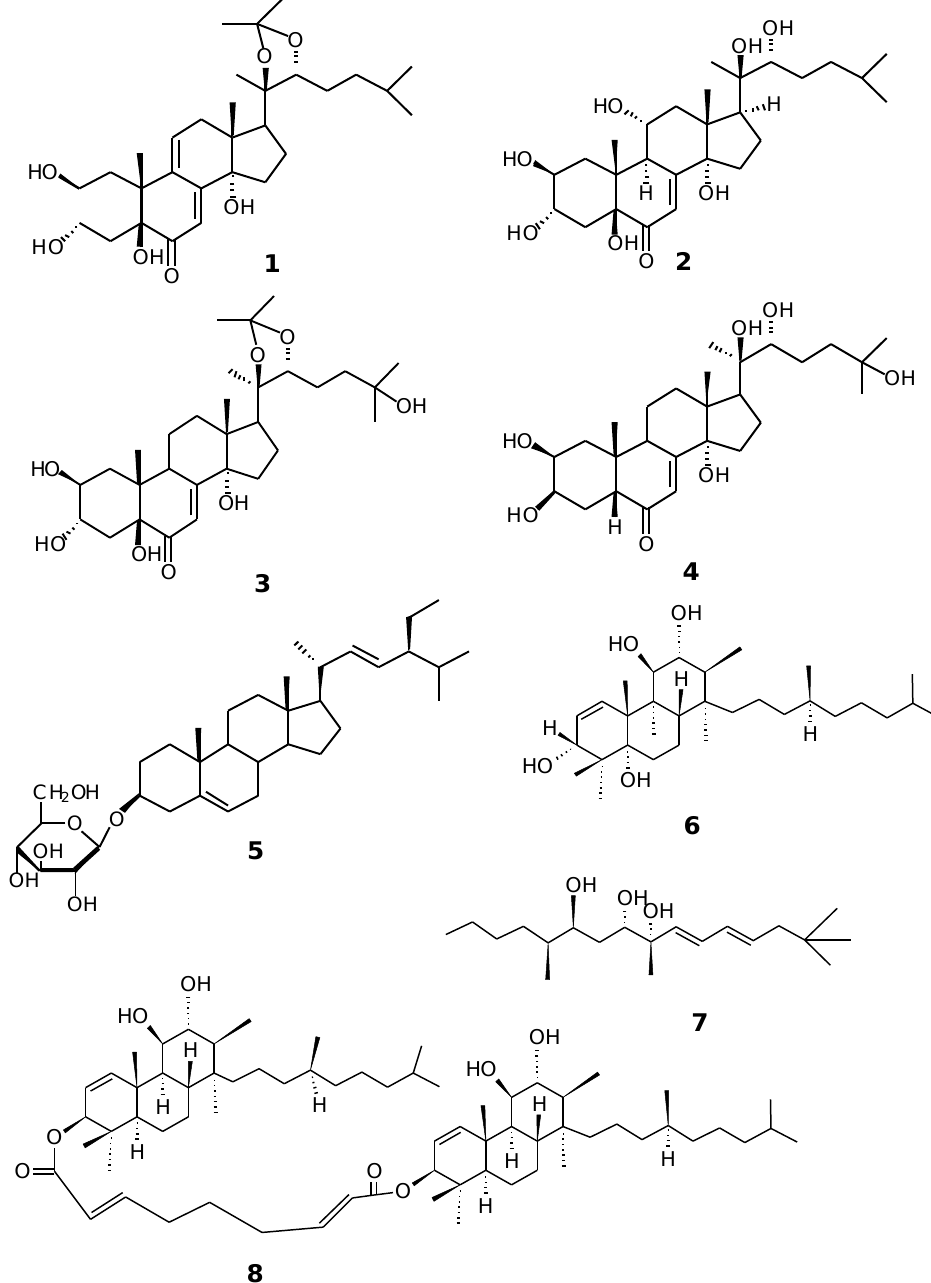
(Table 3), their mineral content (Table 4), the percent composition of the oil (Table 5) the fatty acid (Table 6) and the tocopherol profiles (Table 7) indicated that the plant oil can be considered a substantial source of essential nutrients and may be used as food once its toxicity profile is established. Figure 3. Phytochemicals isolated from I. hederacea : A-20,22- ( 4